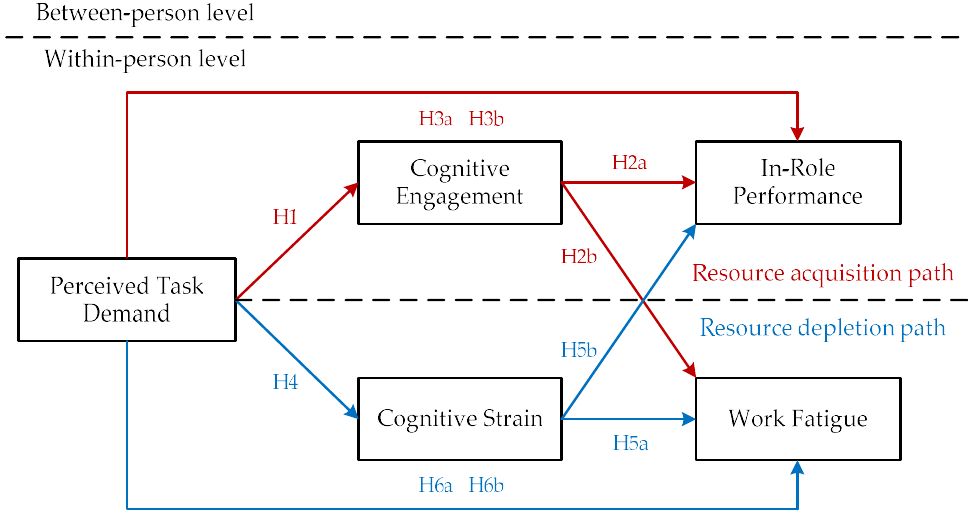
Figure 1. The dual-path model.